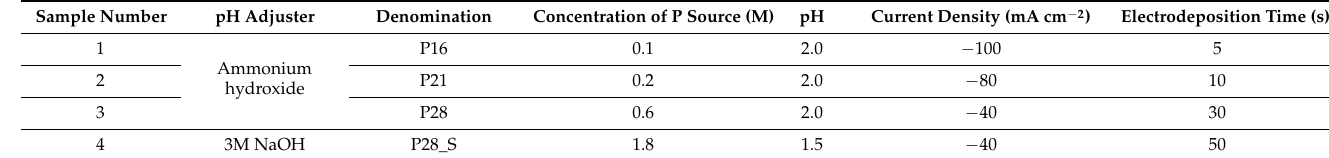
Table 1. Preparation conditions of nickel phosphide thin